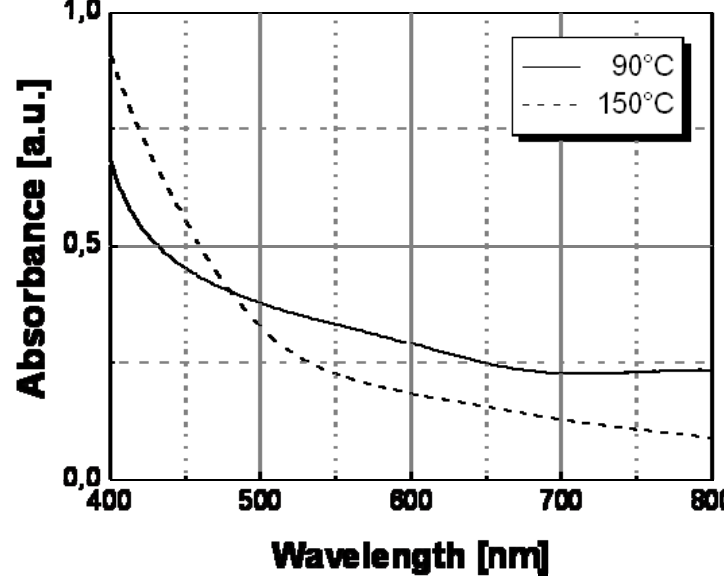
Figure 11. Absorption spectra recorded at two different temperatures for Ag/PS films obtained by thermal decomposition of HO(CH